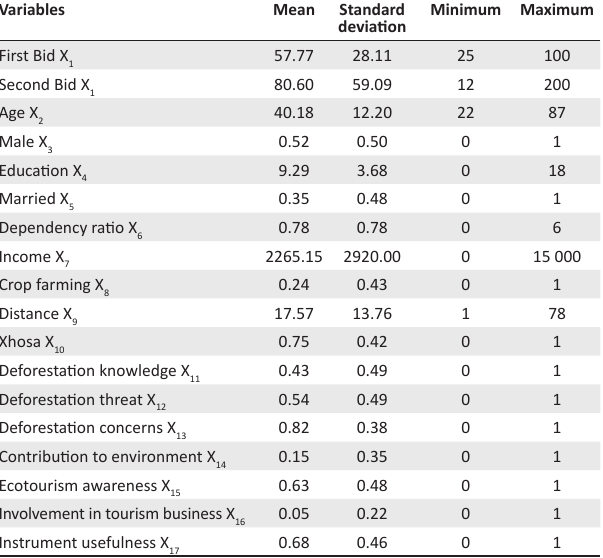
TABLE 3: Descriptive statistics of independent